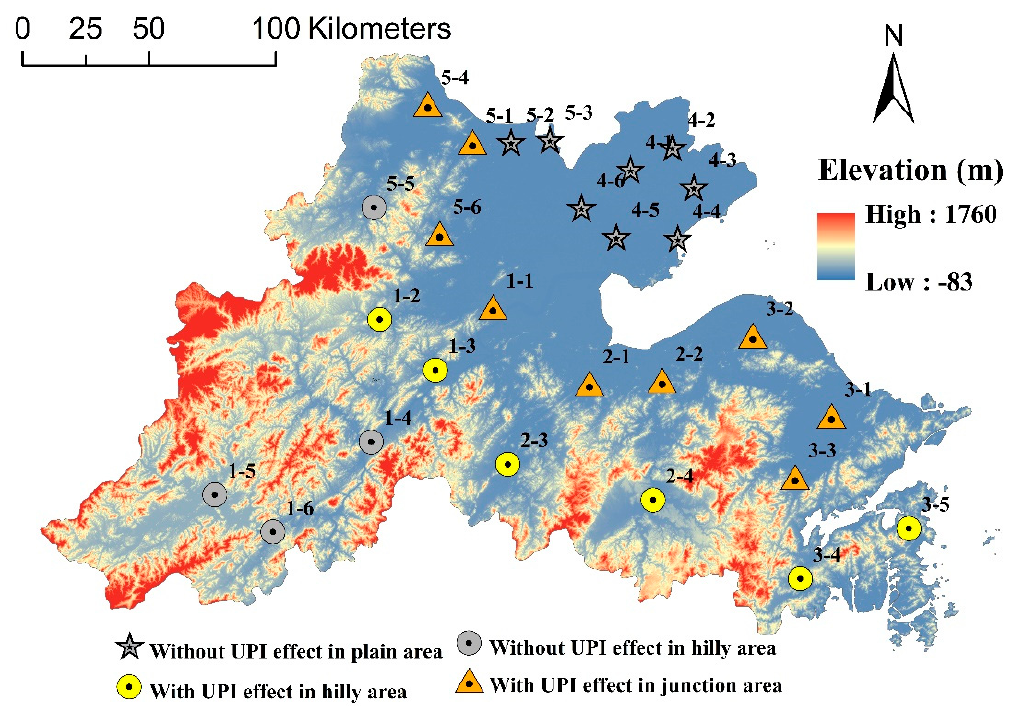
Figure 11. Division of the urban areas by the terrain.